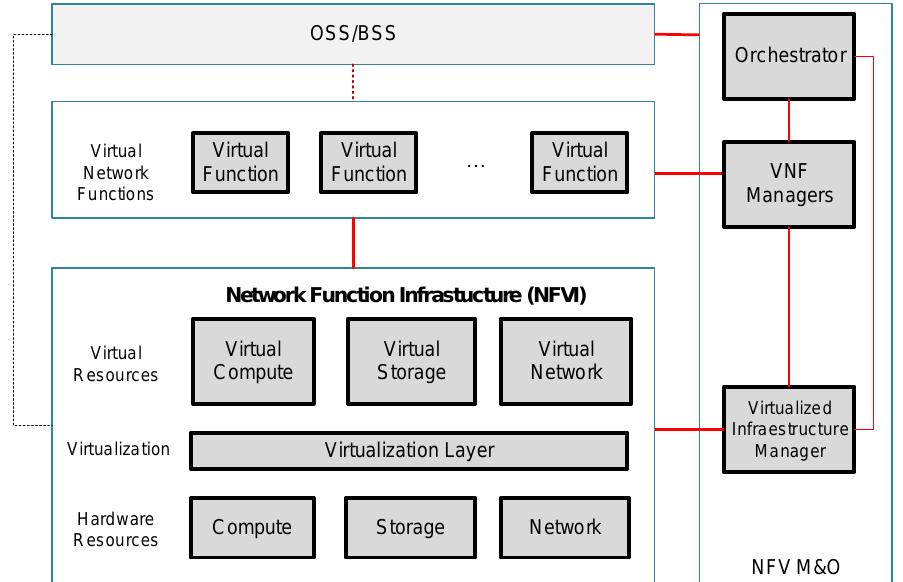
Figure 3. NFV architecture. Figure 3. NFV